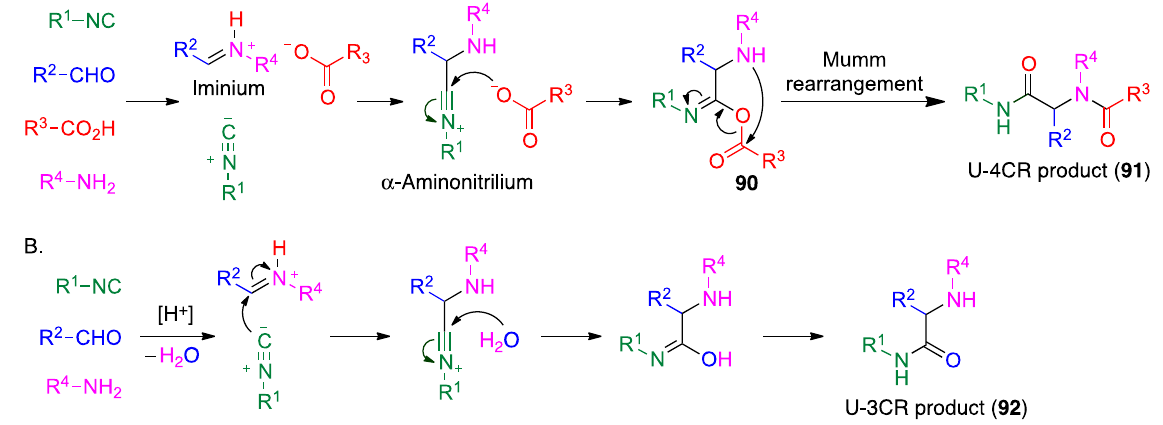
Scheme 41. The Ugi ‐ 4CR ( A ) and Ugi ‐ 3CR ( B ) reactions and their mechanisms.